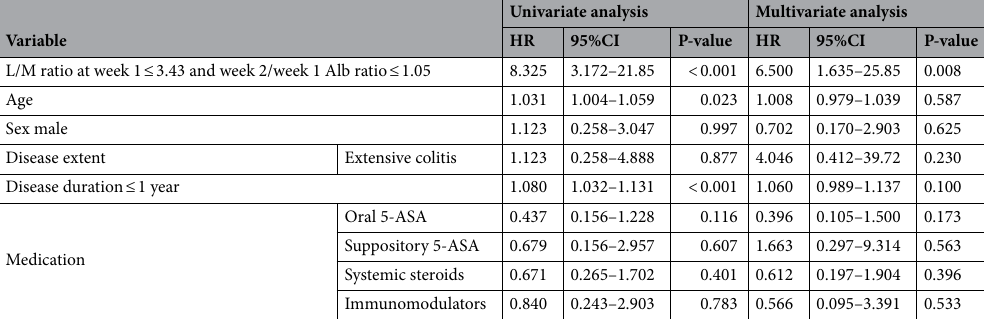
Table 4. Multivariate analysis for predicting failure 3 months following tacrolimus induction. HR, hazard ratio; CI, confidence interval; Alb, albumin; L/M ratio, lymphocyte-to-monocyte ratio; 5-ASA, 5-aminosalicylic